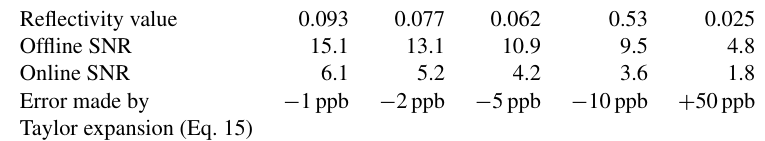
Table 2. Error on the statistical bias estimation by using the Taylor expansion instead of using a truncated normal distribution (cf. Fig.